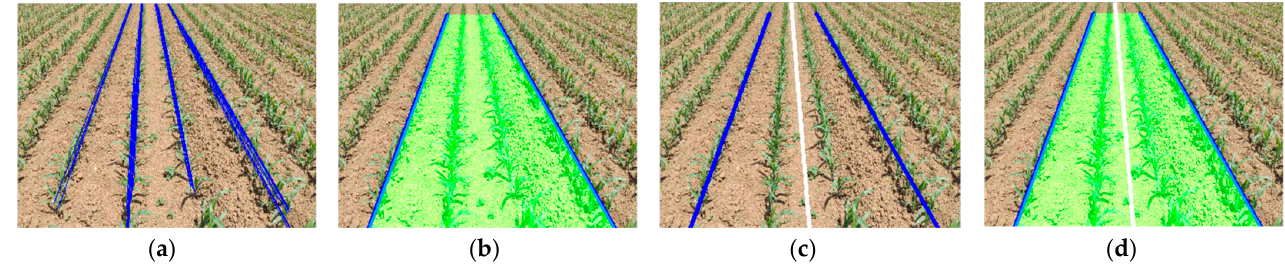
Figure 8. ( a ) Hough transform; ( b ) auxiliary lines; ( c ) guidance line; ( d ) final